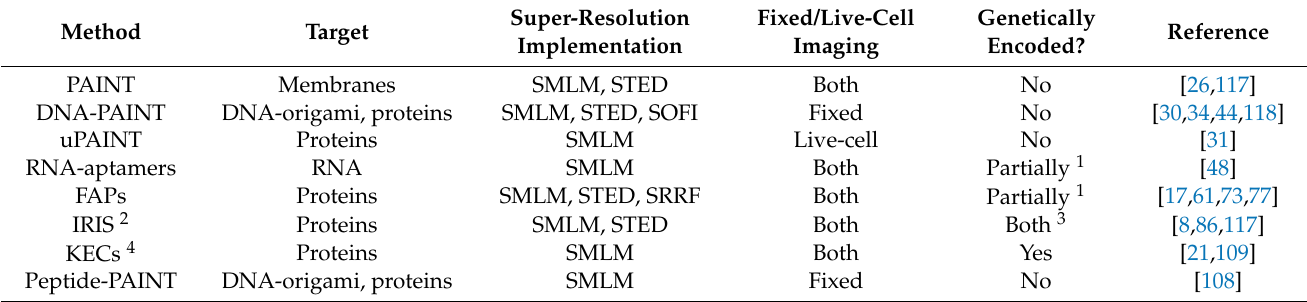
Table 2. Summary of the methods presented in this